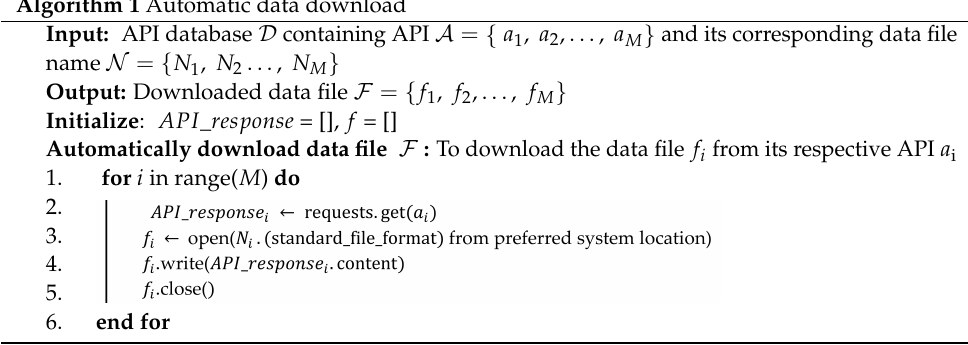
Algorithm 1 Automatic data